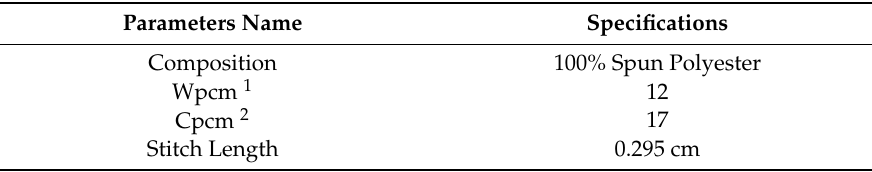
Table 1. Fiber, yarn, fabric, and machine